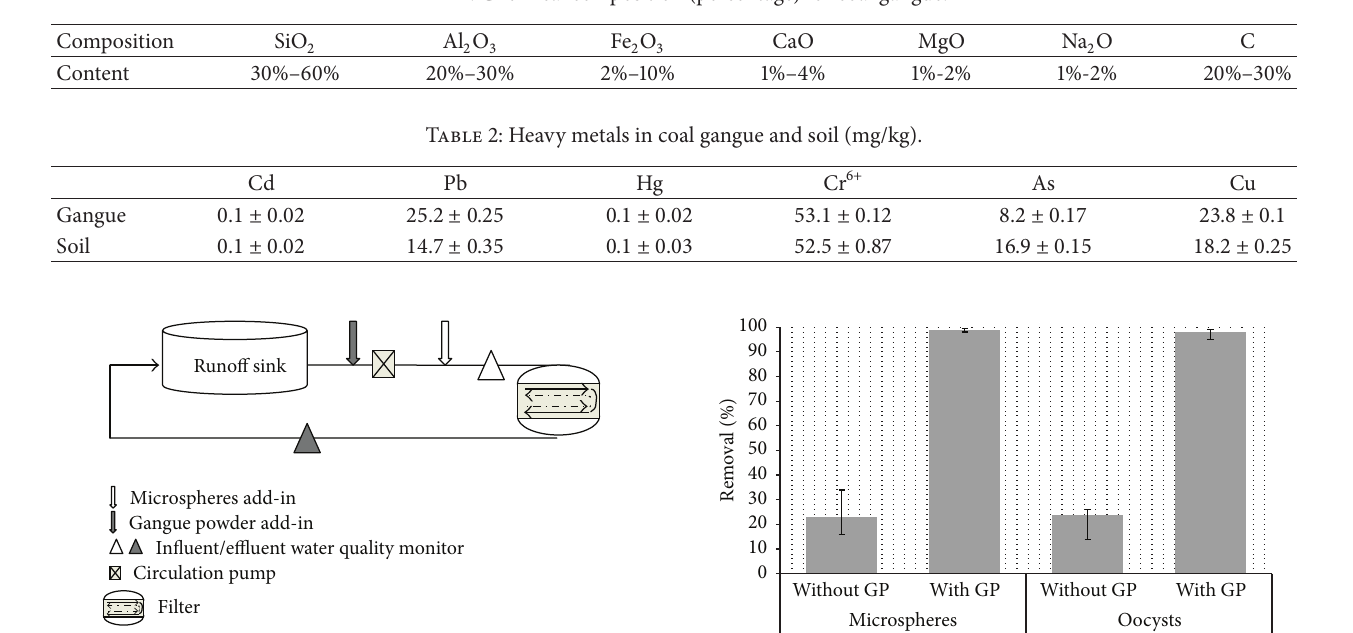
Table 1: Chemical composition (percentage) for coal gangue.